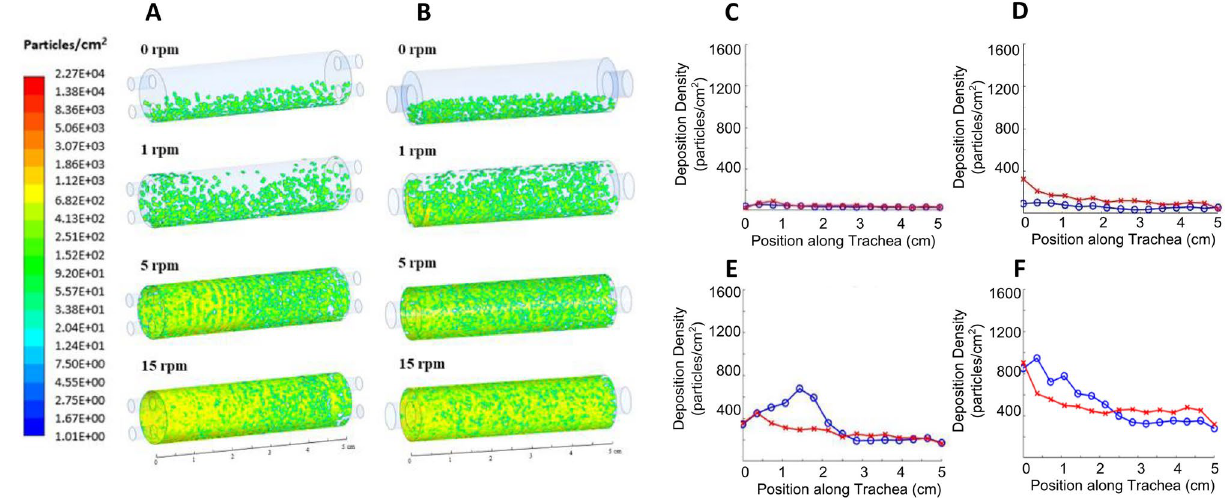
Figure 3. Particle deposition density. Particle deposition density contours of the double ( A ) and single ( B ) inlet designs. Particle deposition density plots at 1.5 mL/min of the double (blue) and single (red) inlet designs at different rotational speeds: 0 rpm ( C ), 1 rpm ( D ), 5 rpm ( E ), and 15 rpm ( F ). ( A ) and ( B ) were generated using ANSYS Workbench v19.1 (ANSYS Inc., Cannonsburgh, PA, USA; https ://www.ansys .com). ( B , C – F ) were generated using MATLAB 2018b (Mathworks Inc., Natick, Massachusetts, USA; https ://www.mathw